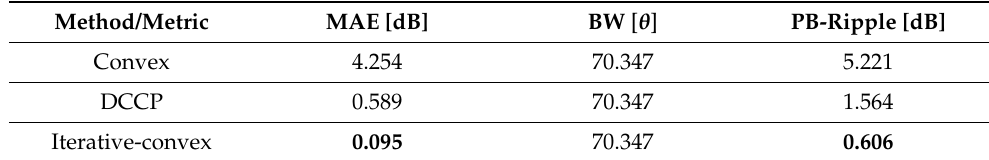
Table 3. The measurements between the desired ramp beampattern and the optimized beampatterns measured in the main lobe interval with BW = 70 ◦ . The best measurement values achieved are marked out in bold.